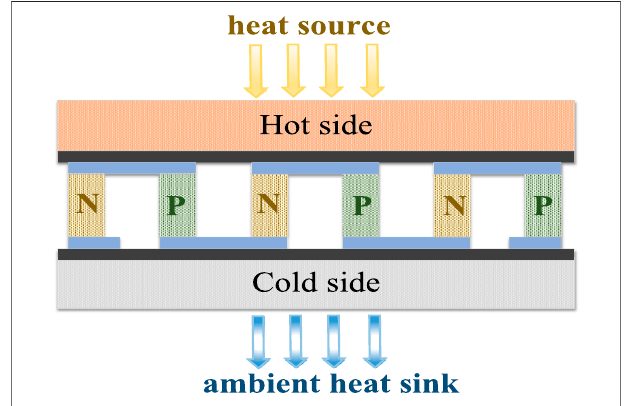
FIGURE 1 | Basic structure of the thermoelectric generation (TEG)